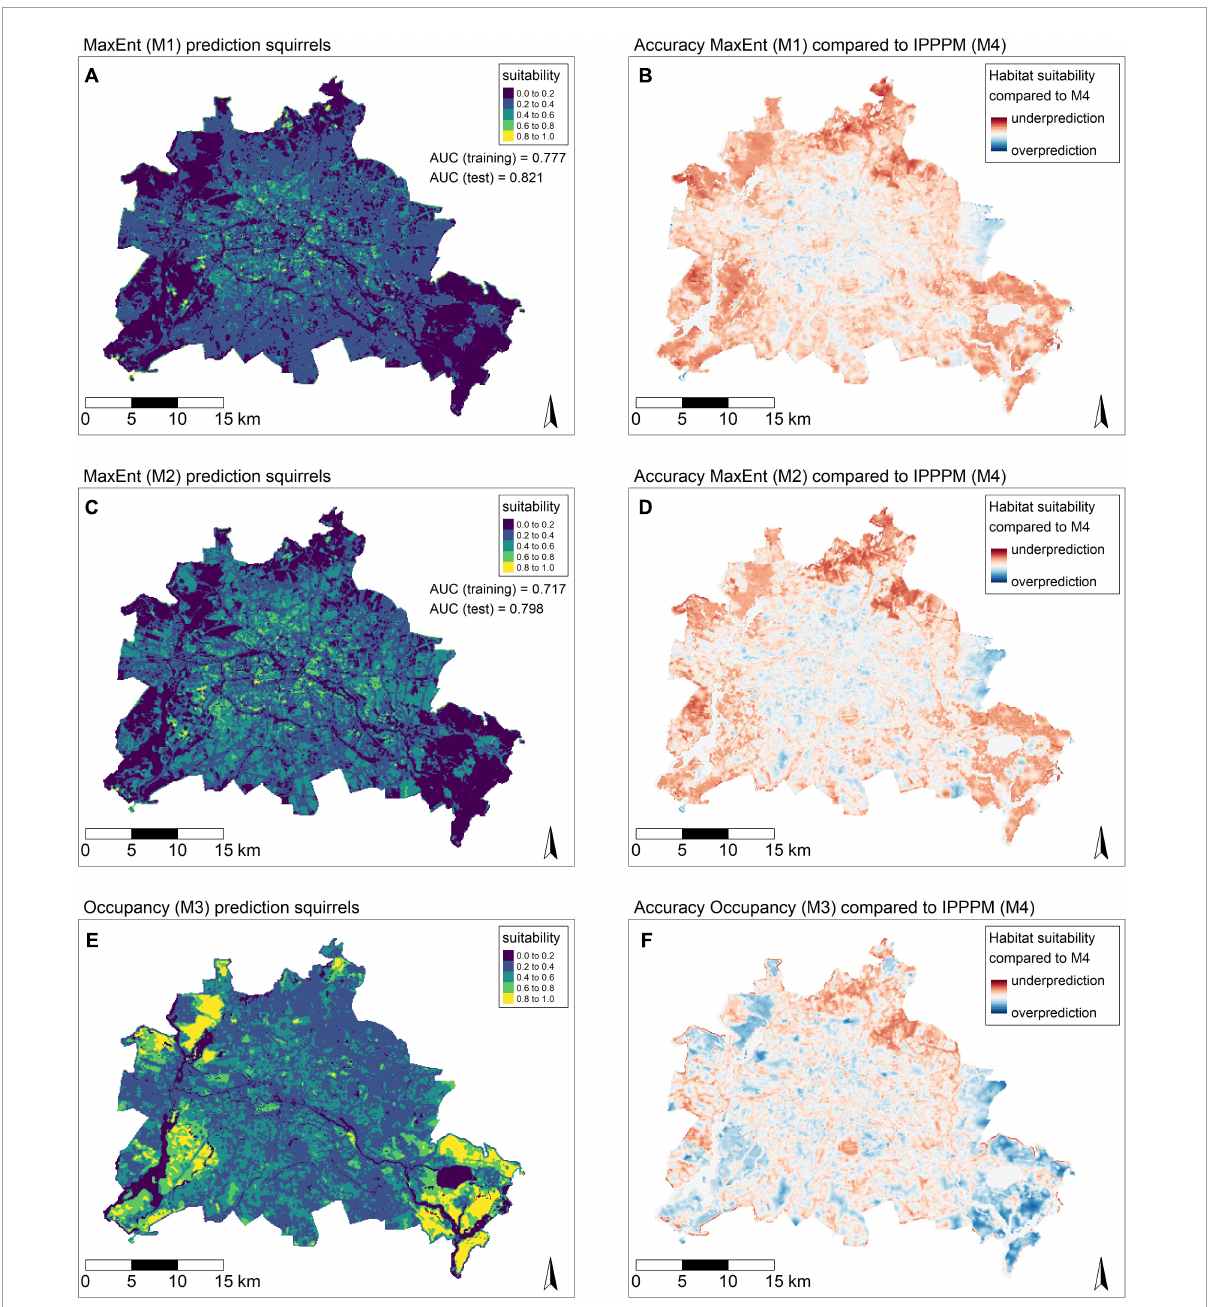
FIGURE5 Comparison of the single distribution models for red squirrels in Berlin. Left side: predicted models, right side: Difference between reference model and respective model (overprediction = blue, underprediction = red). (A) MaxEnt model based on unstructured data set provided by participants. (B) Difference between reference model (M4) and MaxEnt model. (C) MaxEnt model based on unstructured data set provided by participants and camera traps with ≥ 1 observations. (D) Difference between reference model (M4) and MaxEnt model. (E) Occupancy model with semi-structured data set. (F) Difference between reference model (M4) and occupancy model.